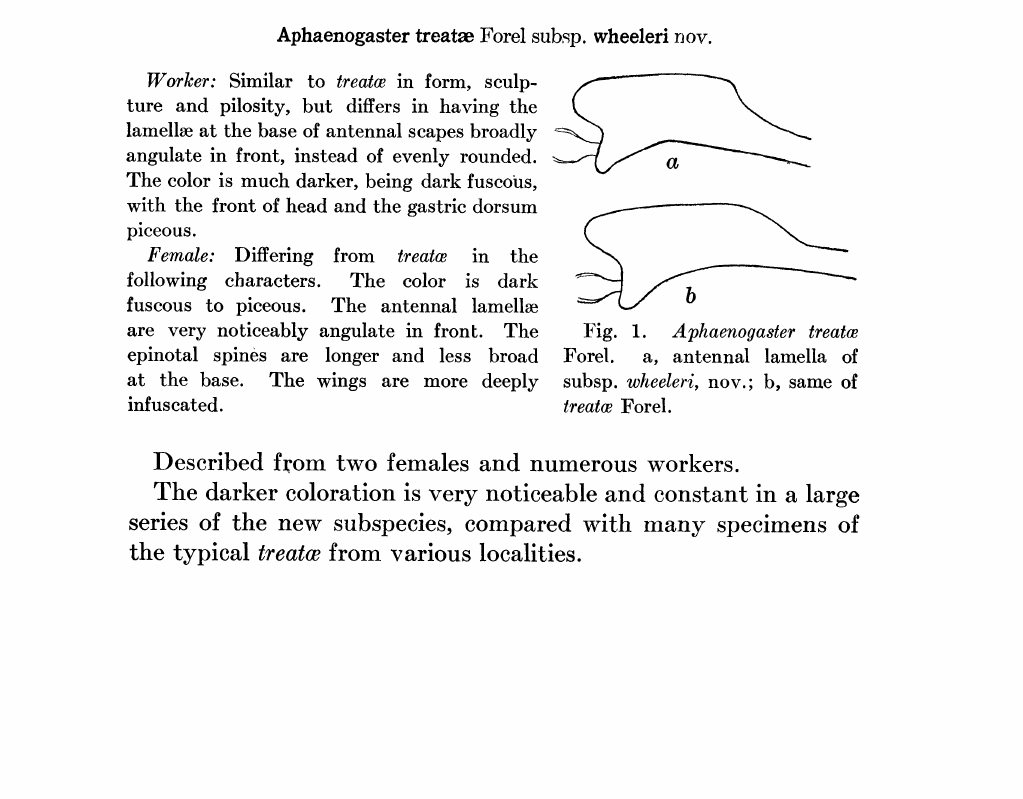
Fig. 1. A phaenogaster treate Forel. a, antennal lamella of subsp, wheeleri, nov.; b, same of treatae